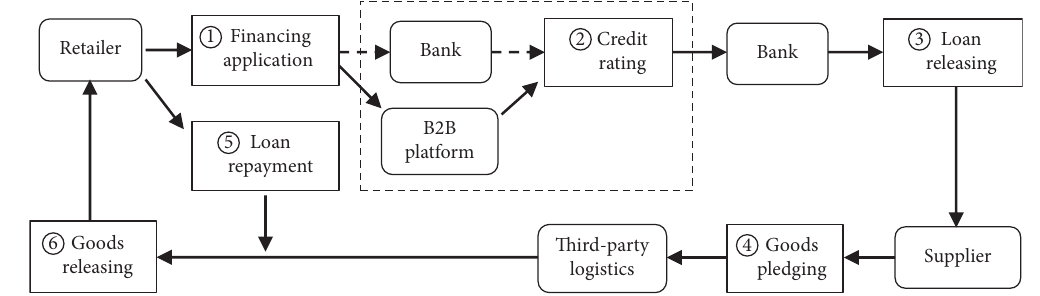
Figure 1: A simplified flowchart of online purchase order